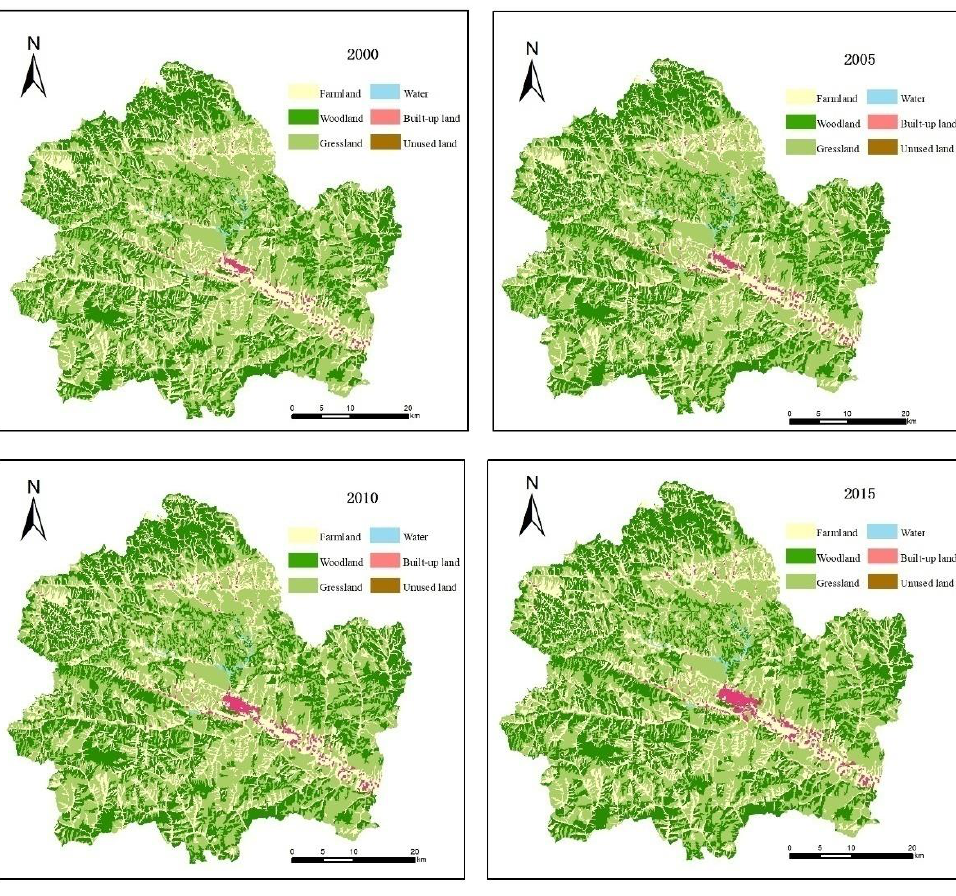
Int. J. Environ. Res. Public Health 2019 , 16 , x Figure 2. Land use space change in Shangzhou district. Figure 2. Land use space change in Shangzhou district.